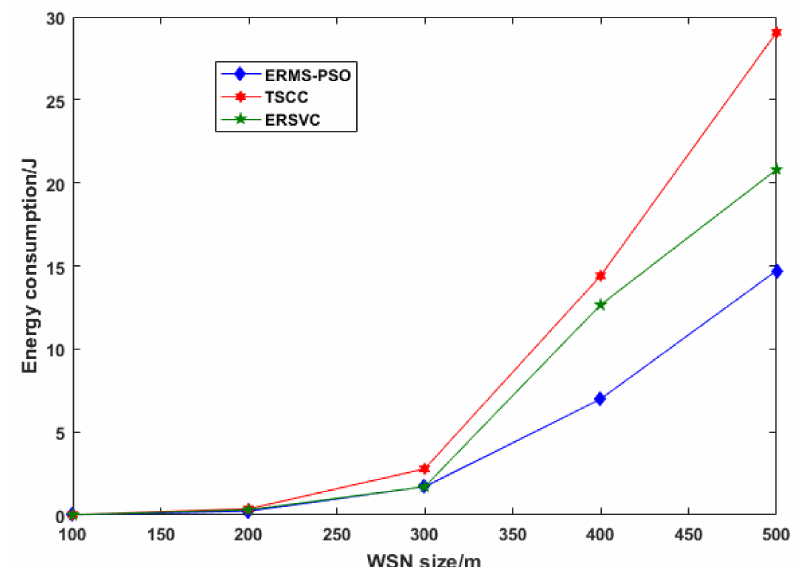
Figure 4. Energy consumption.